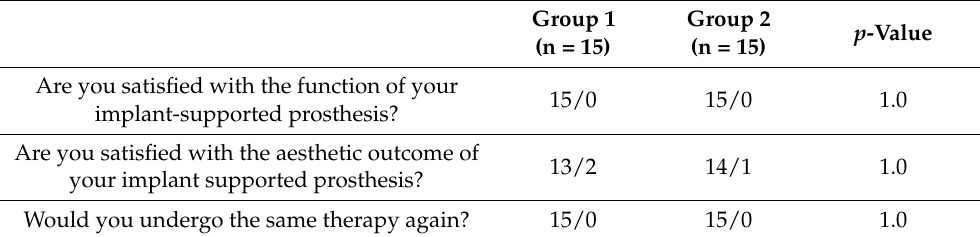
Table 4. Patient’s degree of satisfaction